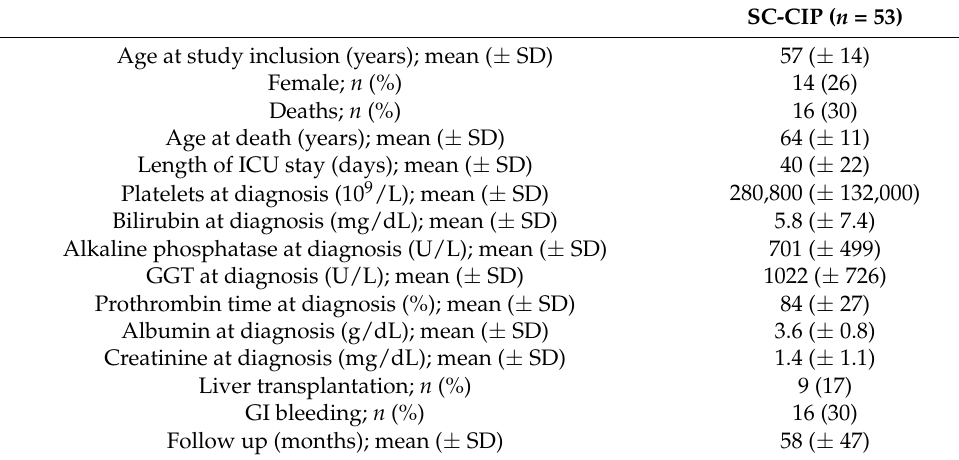
Table 1. Baseline characteristics of patients with SC-CIP included in the analysis.